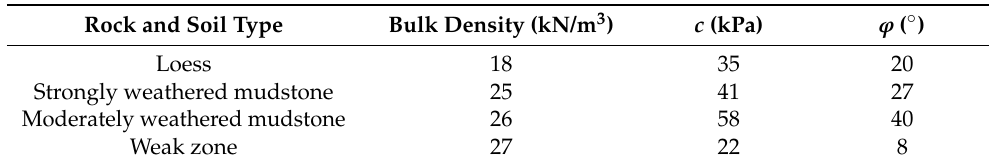
Table 2. Calculation parameters of finite element numerical simulation before landslide in the Tanshan Coal Mine.